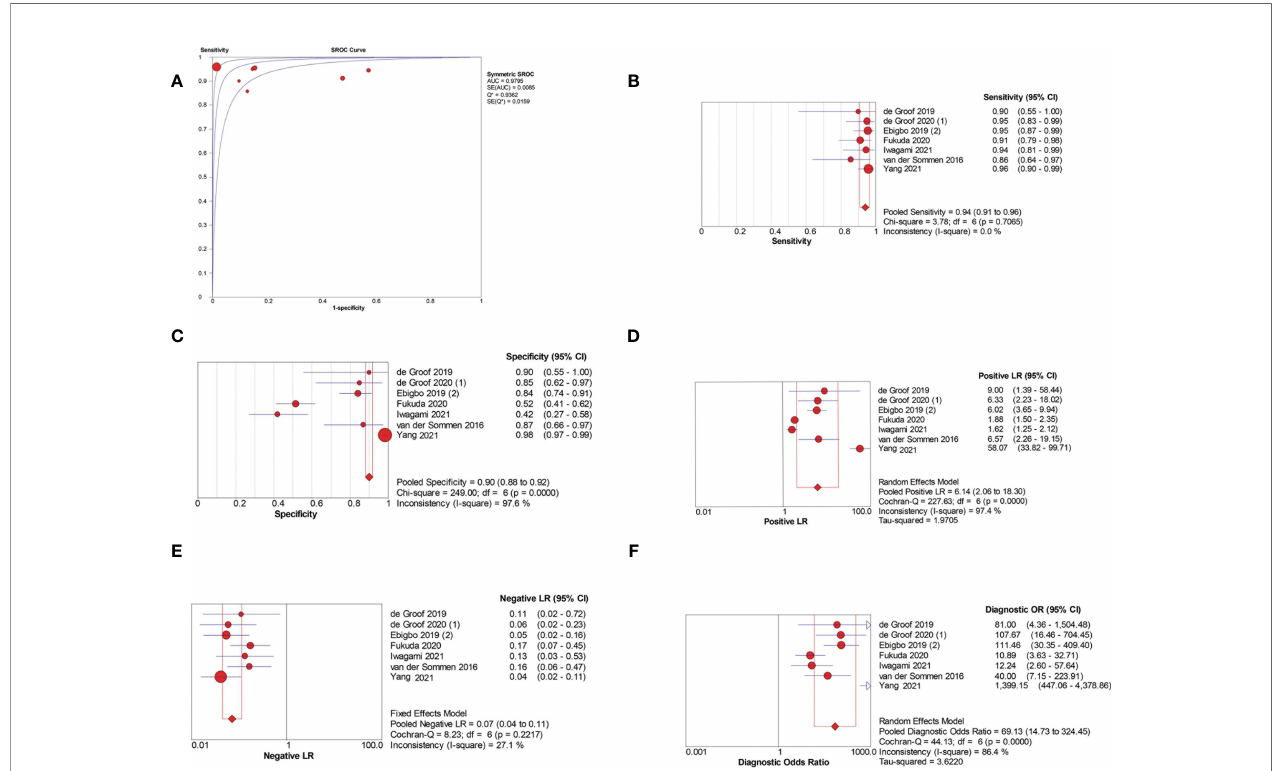
FIGURE 4 | Meta-analysis of AI-assisted EEC diagnosis (patient-based analysis). (A) SROC curve. (B) Pooled sensitivity. (C) Pooled speci fi city. (D) Pooled PLR. (E) Pooled NLR. (F) Pooled